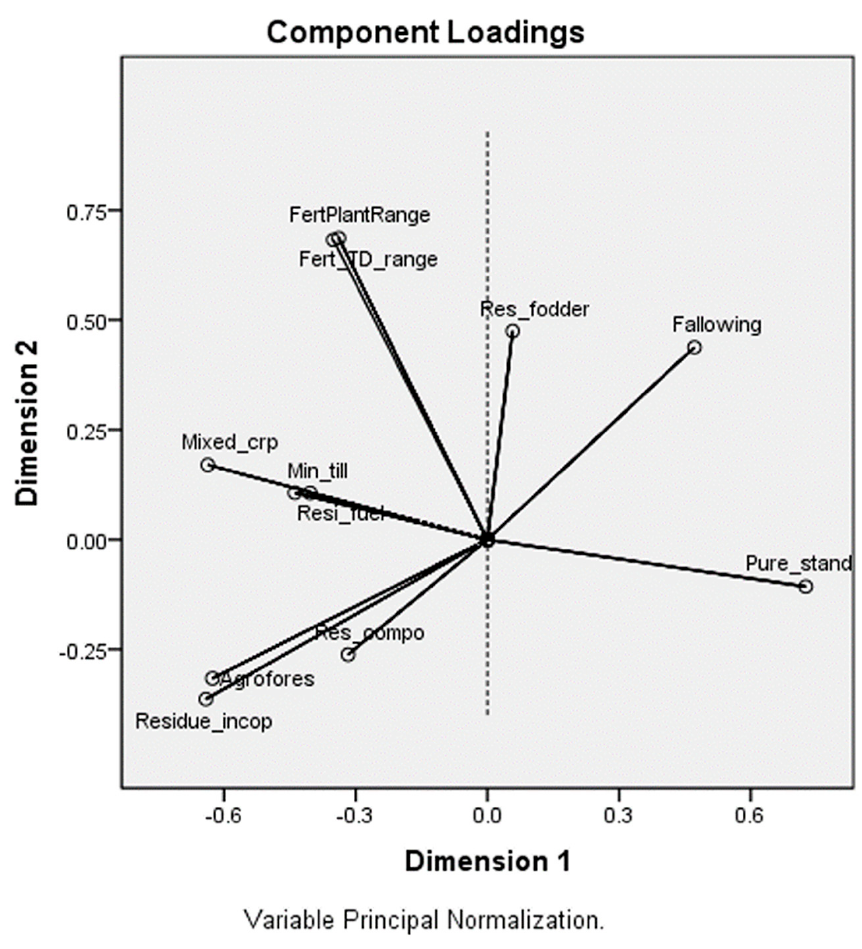
Figure 4. Correlation biplot showing the relationship between soil fertility management practices.